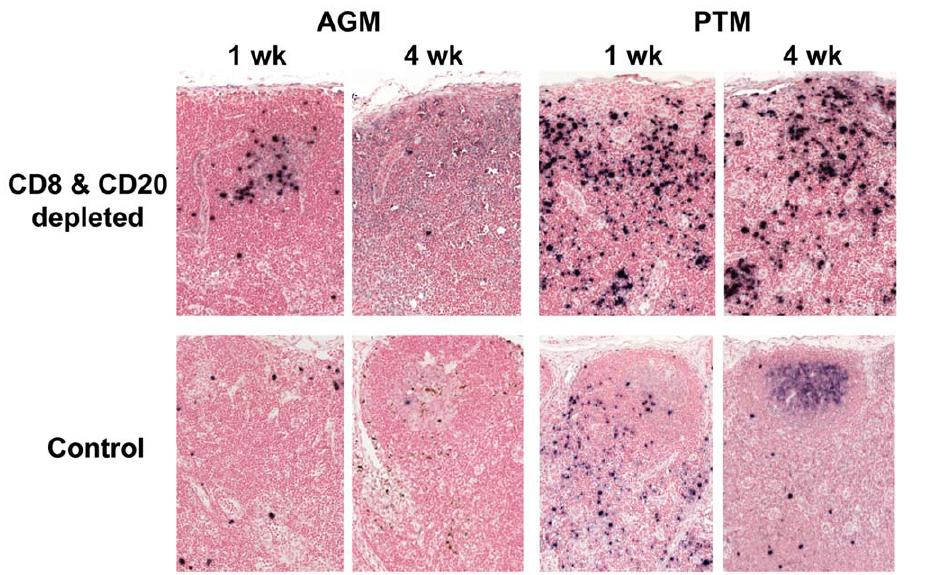
Figure 4. CD8 + and CD20 + lymphocyte depletion in SIV agmVer90 -infected PTM results in enhanced virus replication in contrast to AGM. Representative SIV-specific in situ hybridization of lymph nodes collected at one and four weeks p.i. from a vervet AGM (left) and PTM (right). Top panels show samples from CD8 + and CD20 + lymphocyte-depleted animals and bottom panels show samples from historical control animals. Active viral replication in SIV positive cells is marked in black